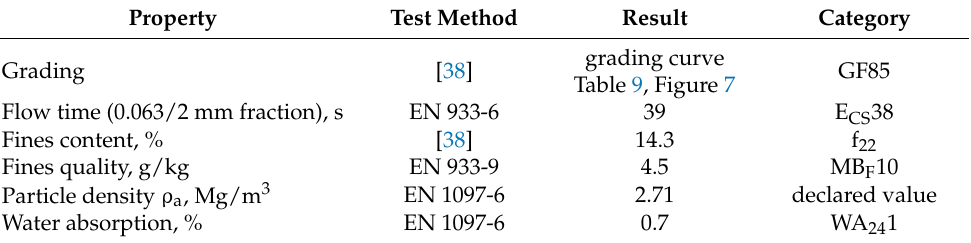
Table 10. Geometric and physical properties of the virgin aggregate (VA) acc. EN